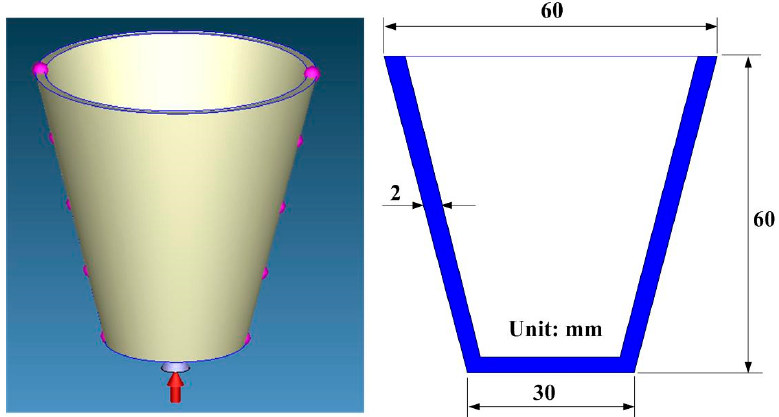
Figure 1. CAD model and cross section of the injection molded part.